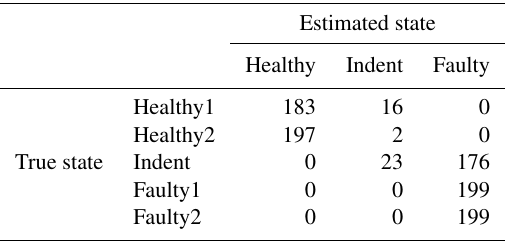
Table 7. Confusion matrix for 3000rpm MEMS data and the top four features, classifier trained with ramp-up data.